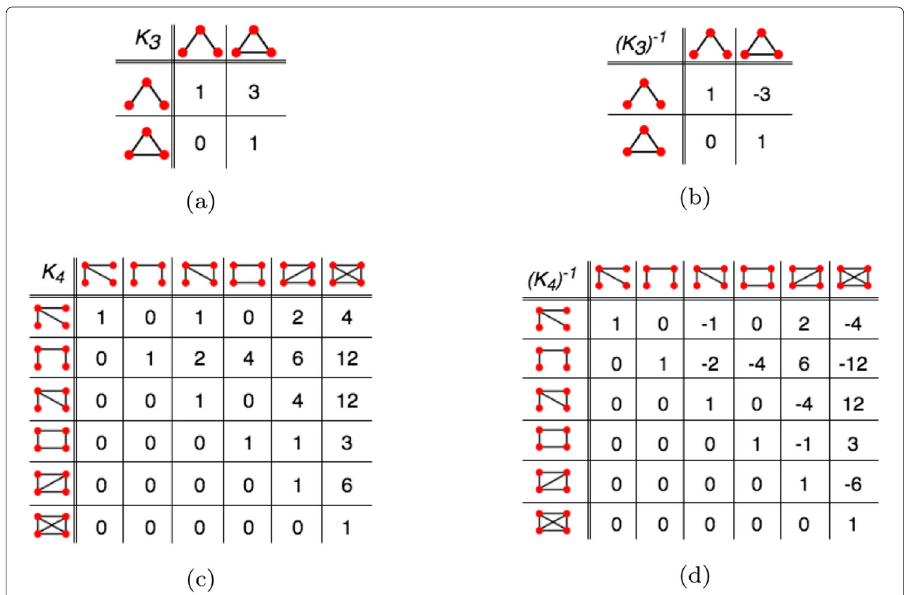
Fig. 2 Kocay matrices and their inverse: (a) The Kocay matrix K 3 for 3-nodes subgraphs, (b) The Inverse of Kocay matrix K 3 , (c) The Kocay matrix K 4 for 4-nodes subgraphs, (d) The Inverse of Kocay matrix K 4